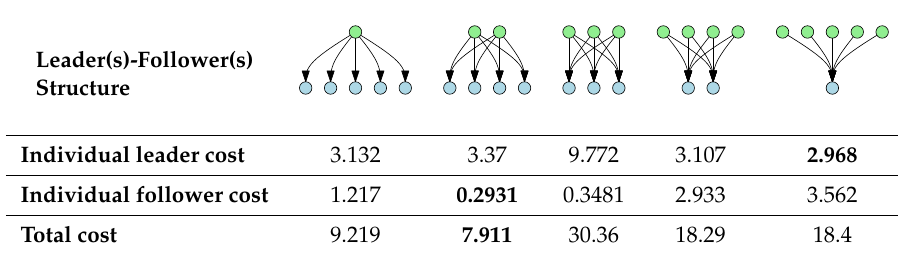
) for the different number of leaders in the , ¯ α follower , and S ( |I L | , δ x 0 0 0